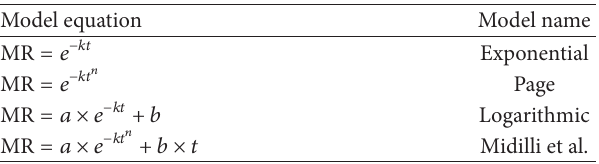
Table 1: Mathematical models given by various authors for drying